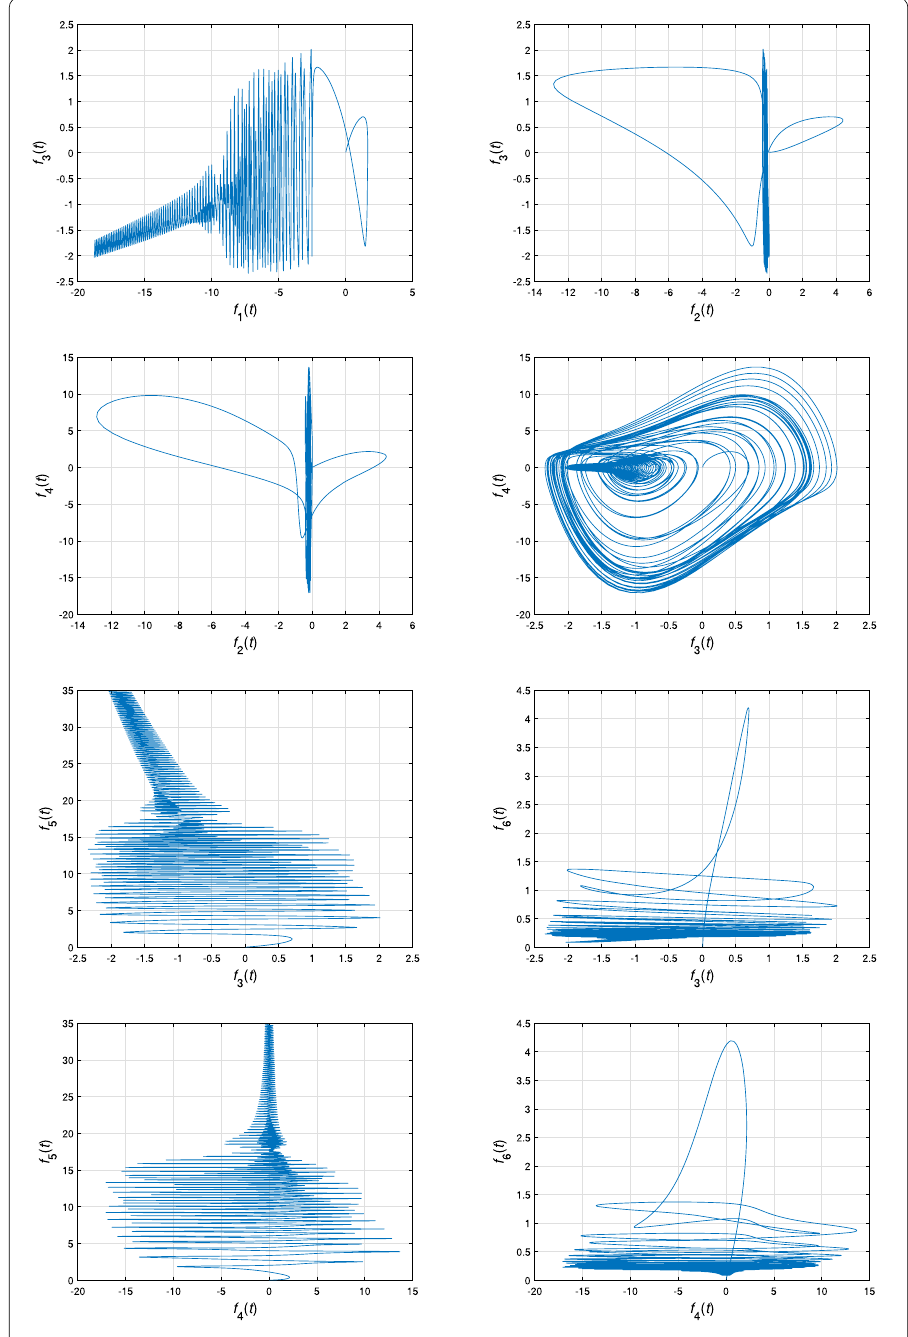
Figure 1 Two-dimensional phase planes of the integer cardiac conduction model (2)